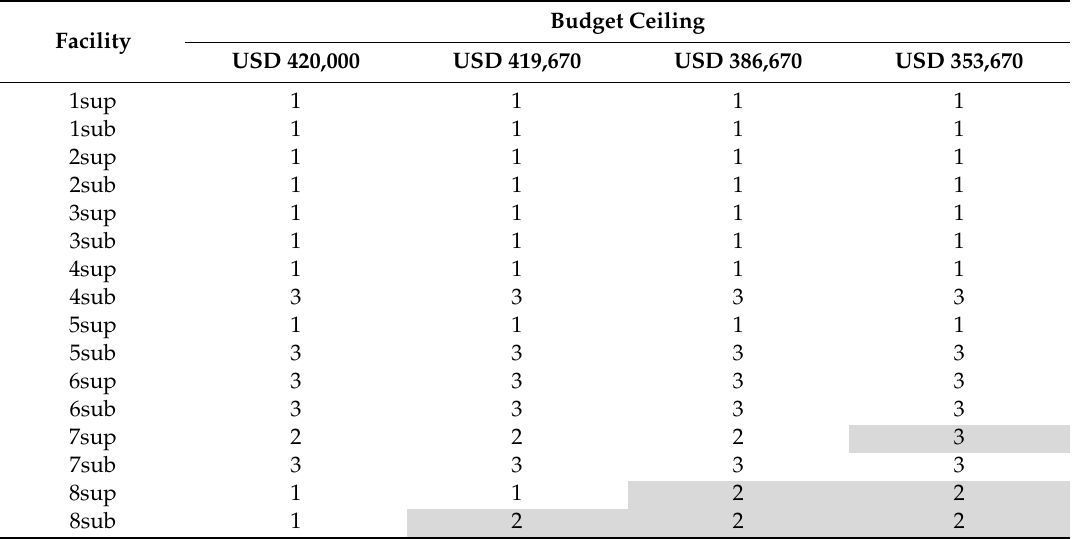
Table 15. Plan selection impact of budget ceiling variation (1st plan period) compared with base budget USD